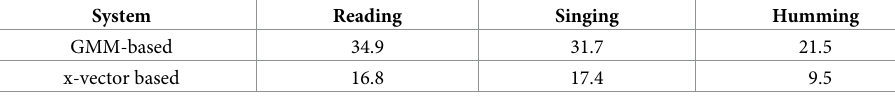
Table 4. EER% on the TI-GI ASV tasks, using three types of single-speaking styles